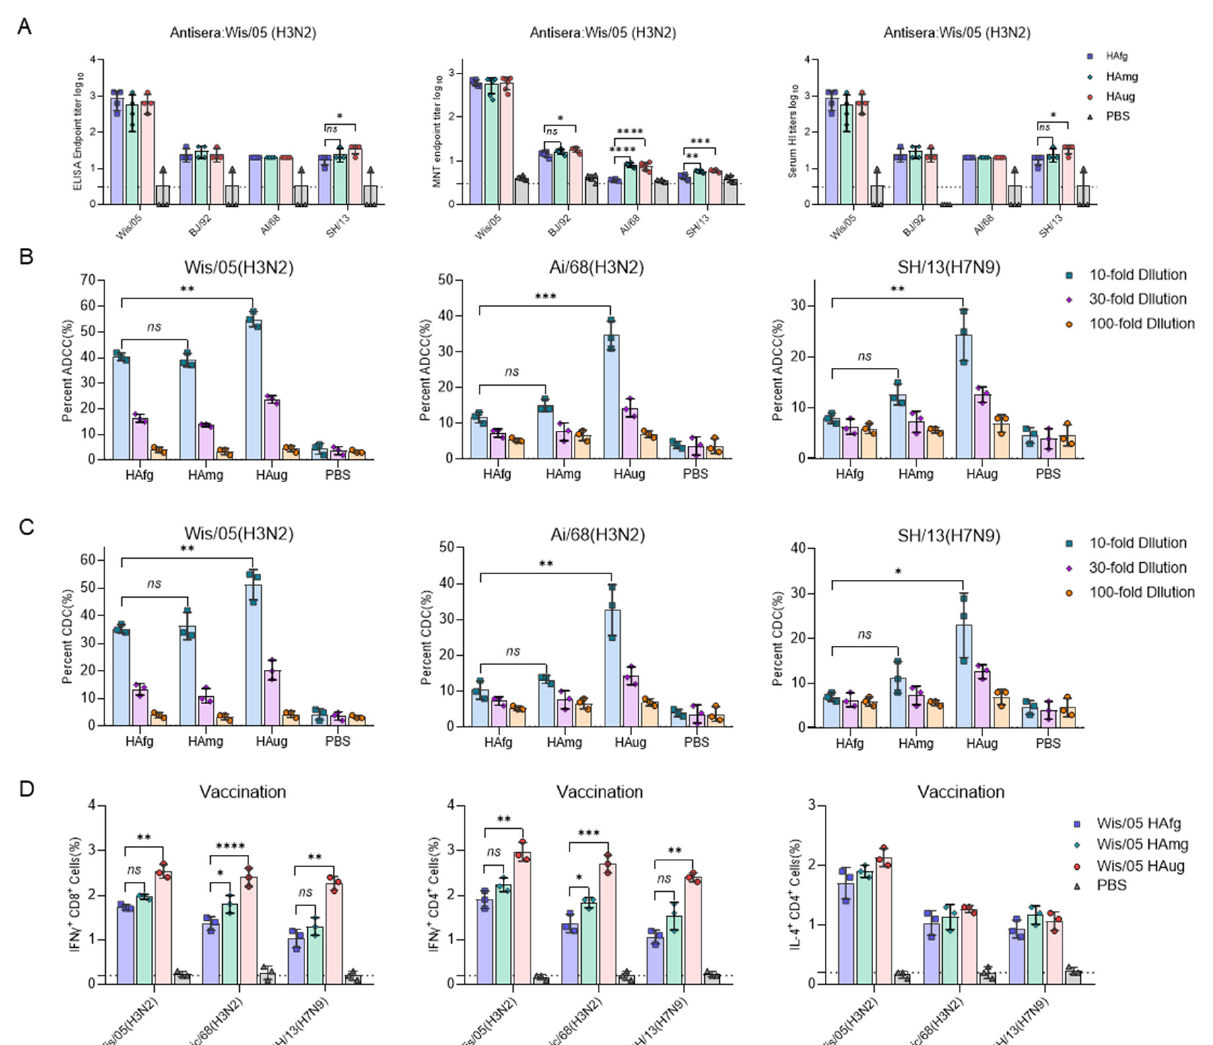
Figure 2. Vaccination of mice with deglycosylated modified HA elicits a strong T-cell response and antibody-dependent effector functions against H3 and H7 viruses. BALB/c mice (six mice in each group) were immunized with 15 µ g of HA fg , HA mg and HA ug on days 0 and 14. The virus-specific B-cell and T-cell responses were measured on day 28 after boost immunization. ( A ) ELISA endpoint titer, hemagglutination inhibition (HAI) titers and neutralizing antibody titers of immune sera were determined against Wis/05 (H3N2), Vic/11 (H3N2), BJ/92 (H3N2), AI/68 (H3N2), and SH/13 (H7N9). ( B ) ADCC activity of immune sera against Wis/05(H3N2), AI/68(H3N2) and SH/13(H7N9) virus target MDCK cells was measured by flow cytometry using a rapid fluorometric ADCC assay. ( C ) The virus-specific complement-dependent cytotoxicity (CDC) activity of the sera from immunized mice was determined by a complement-mediated cell killing assay. ( D ) Single splenocytes from immunized mice were harvested for the analysis of IFN- γ - and IL-4-secreting T cells determined by an enzyme-linked immunospot (ELISPOT) assay stimulated by specific HA proteins from Wis/05(H3N2), AI/68(H3N2) and SH/13(H7N9). Data are presented as the mean ± SEM. The results were calculated with Prism software using Student’s t test; significant differences are